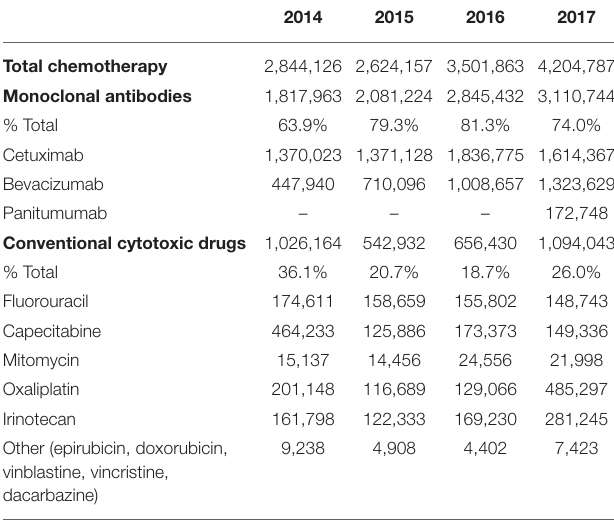
TABLE 2 | Total expenditures ( e ) for chemotherapy in the colorectal cancer patients in Serbia during the 4-year study period by different types of medication